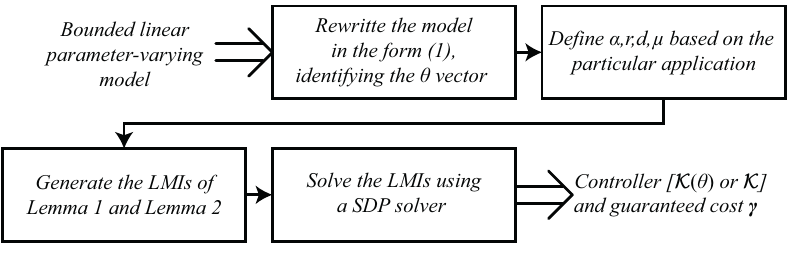
Figure 4. Offline algorithm.